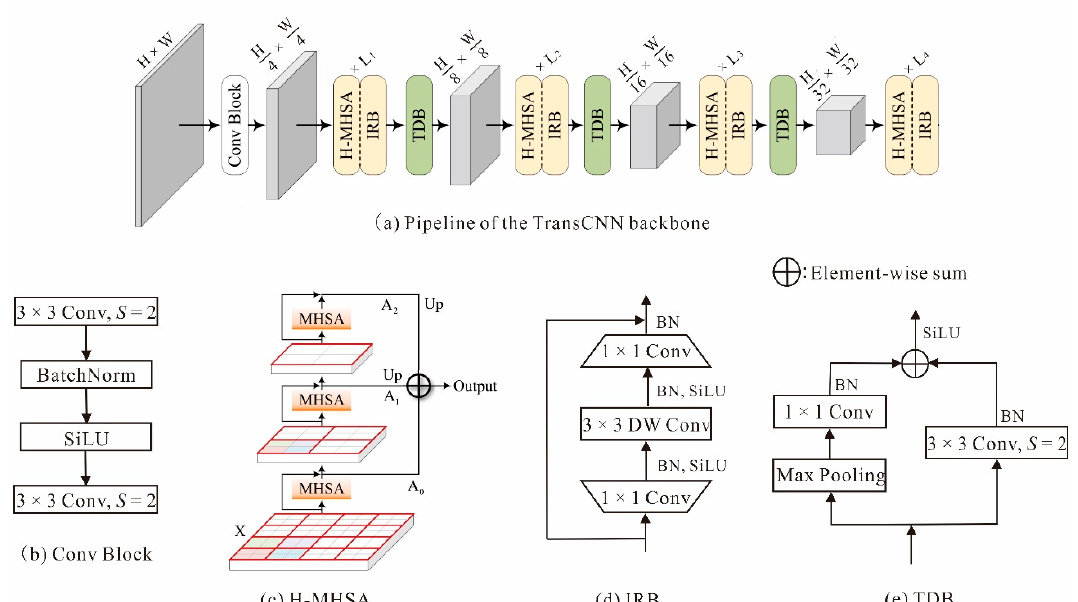
Figure 1. Illustration of TransCNN (modified after [24]). DW Conv represents depthwise separable convolution; TDB: Two-branch Downsampling Block; IRB: Inverted Residual Bottleneck; × Li means that the H-MHSA + IRB block is repeated Li times; S denotes the stride of the convolution; H and W denote the height and width of the input image, respectively; SiLU is the nonlinear activation function.